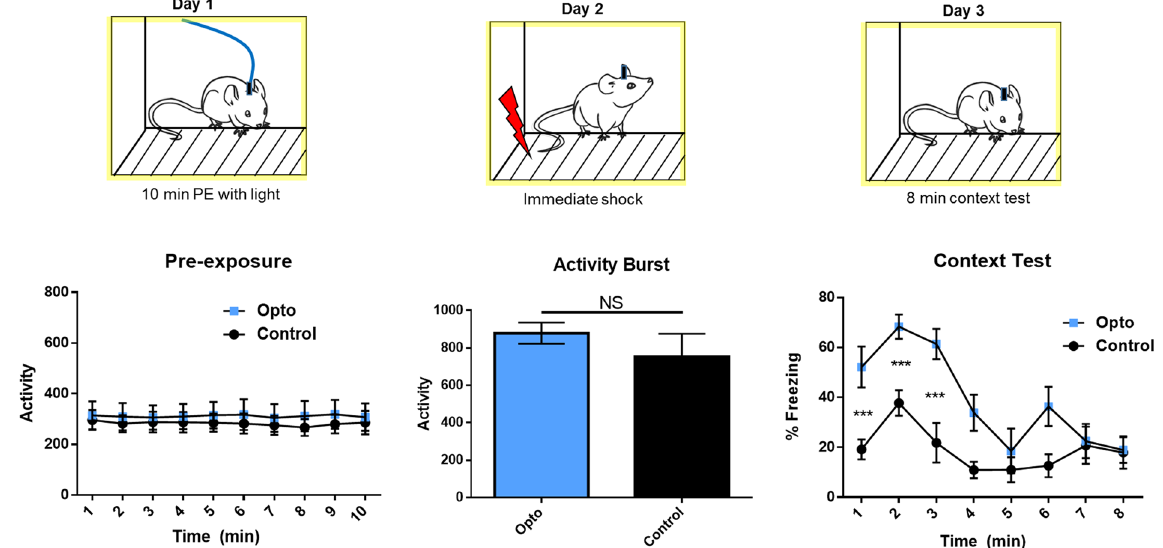
Figure 2. The behavioral protocol is shown above the results from each session. Mice were exposed to a novel context during optogenetic stimulation of medial septum cholinergic neurons (n = 6 Opto and n = 10 Controls); activity did not differ between groups during preexposure (PE) (p > 0.05). The following day, mice were shocked immediately (10 sec) after placement in the context (n = 6 per group); no difference was observed in freezing before or after shock (data not shown) nor in activity burst to the shock (p > 0.05). Opto mice demonstrated significantly greater freezing the following day at test (p < 0.05).